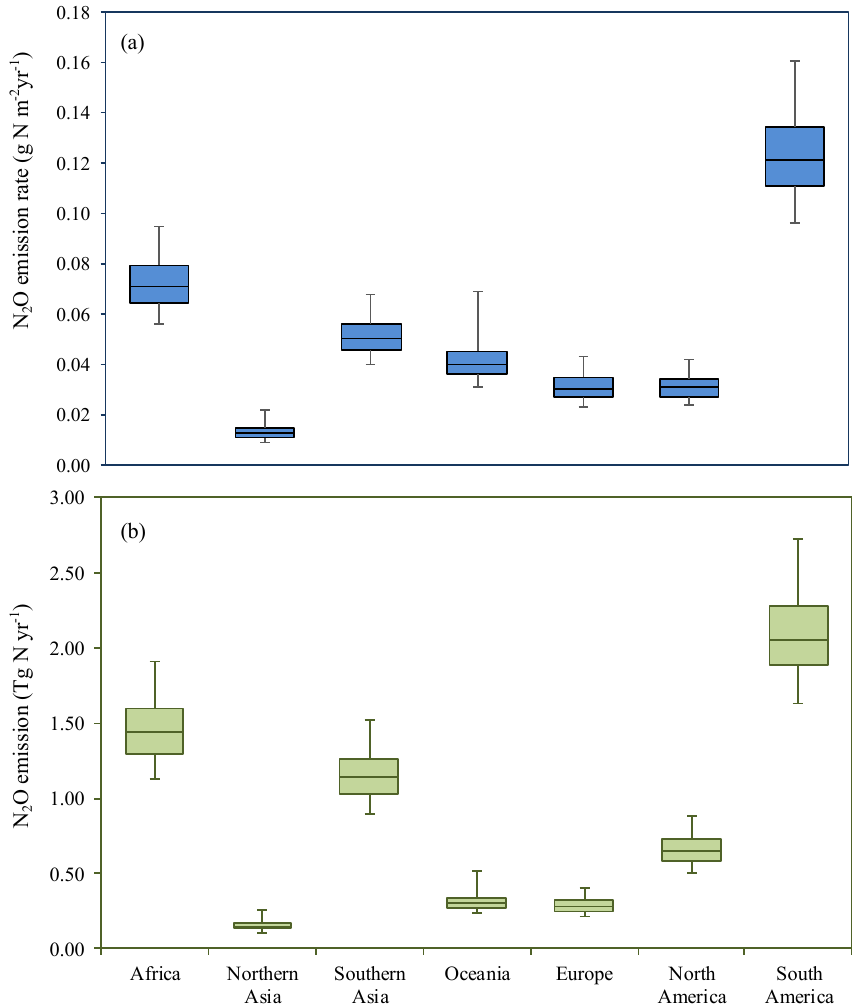
Figure 5. Estimated N 2 O emission rates (a) and emissions (b) with uncertainty ranges at continental level in 1860. Solid line within each box refers to the median value of N 2 O emission rate or